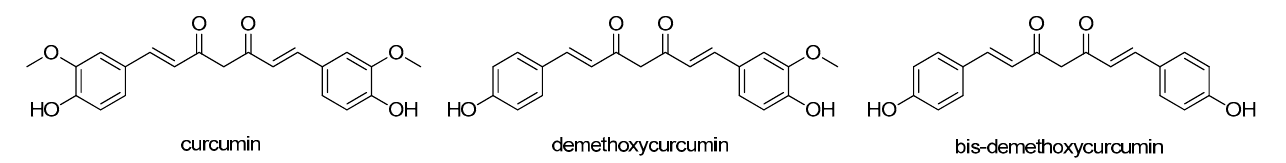
Figure 3. The chemical structures of curcumin and two other curcuminoids naturally present in commercially available curcumin.